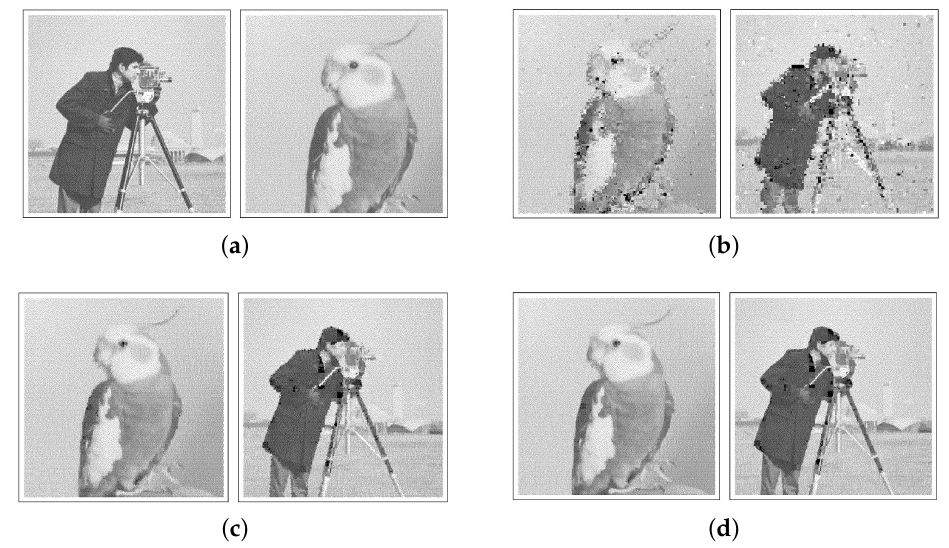
Figure 33. Decompression process for Bird and Cameraman (Reprinted with permission from [47]. Copyright 1997 Springer), ( a ) Seed for Bird (left) and seed for Cameraman (right), ( b ) 2 iterations of Bird IFS (left), 2 iterations of Cameraman IFS (right), ( c ) 4 iterations of Bird IFS (left), 4 iterations of Cameraman IFS (right), ( d ) 6 iterations of Bird IFS (left), 6 iterations of Cameraman IFS